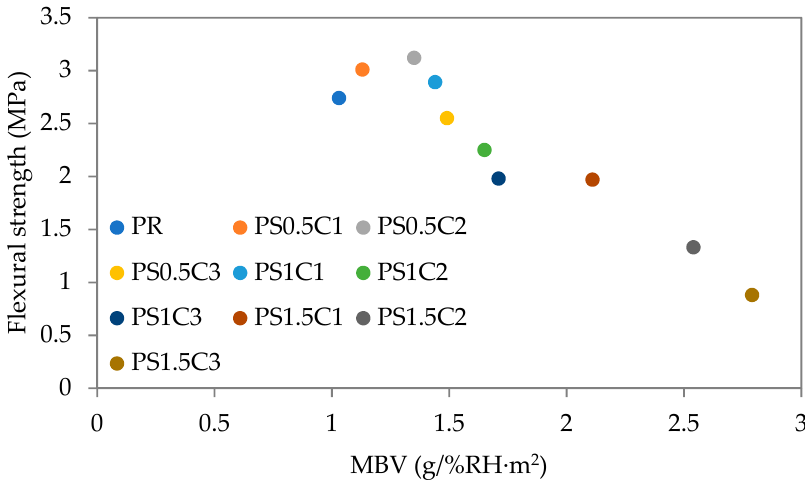
Figure 7. Correlation between moisture buffering and flexural strength.